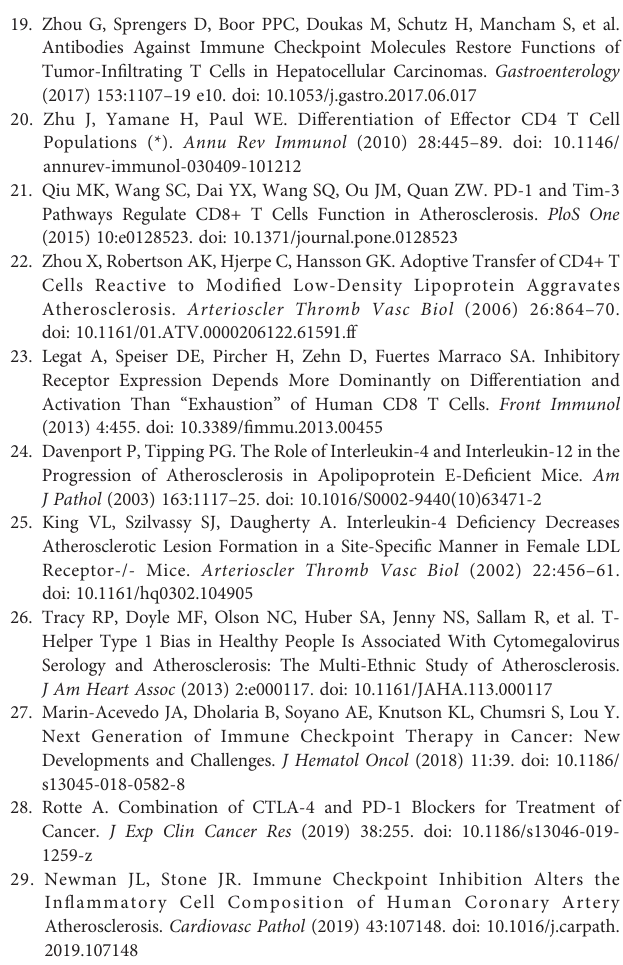
Supplementary Figure 1 | Cytokine production in Tim-3 + PD-1 + CD4 + T and Tim- 3 - PD-1 - CD4 + T cells during LEASO. Quanti fi cation of fl ow cytometric analysis of TGF- b 1, IL-17A and IL-6 on Tim-3 + PD-1 + CD4 + T cells and Tim-3 - PD-1 - CD4 + T cells from LEASO. Data represent mean ± SEM.